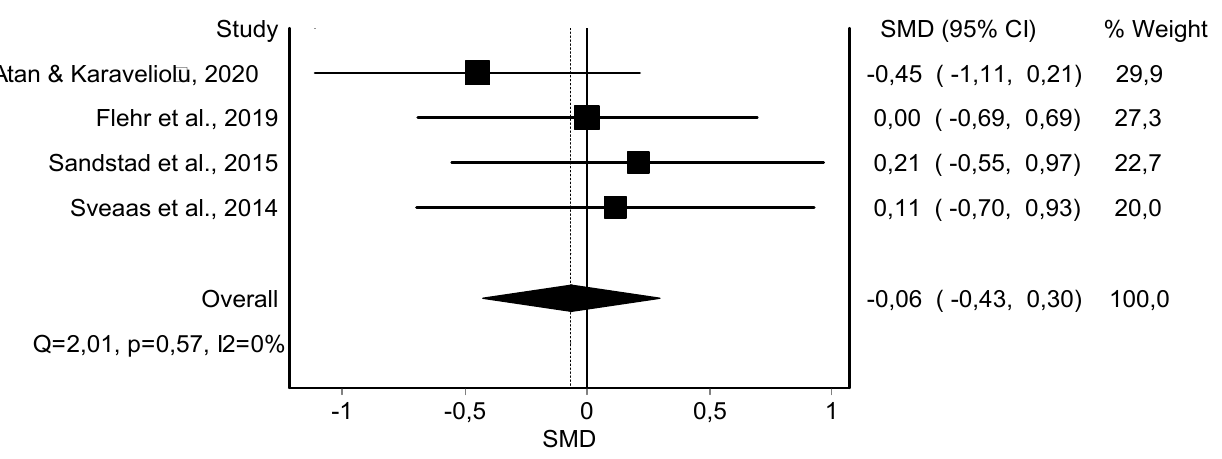
Figure 2. Synthesis forest plot of resting systolic blood pressure variable. If the diagram (diamond- shaped) is in the negative zone (on the left of the figure and without touching the 0 line), it indicates statistically significant differences in favor of the HIIT intervention. The forest plot summarizes the results of included studies (SMD and weight). The small boxes with squares represent the point estimate of the effect size and sample size. The lines on either side of the box represent a 95% CI.